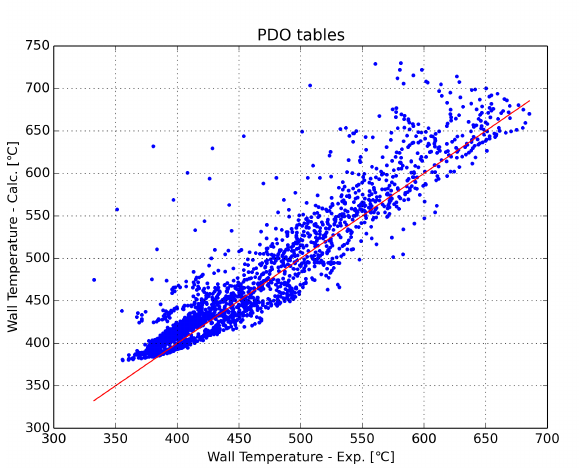
Figure 4. Groeneveld’s look-up PDO tables